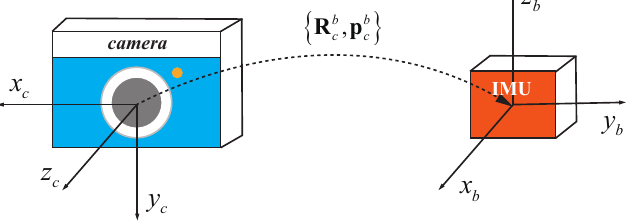
Figure 2. An illustration of the spatial parameters between IMU and